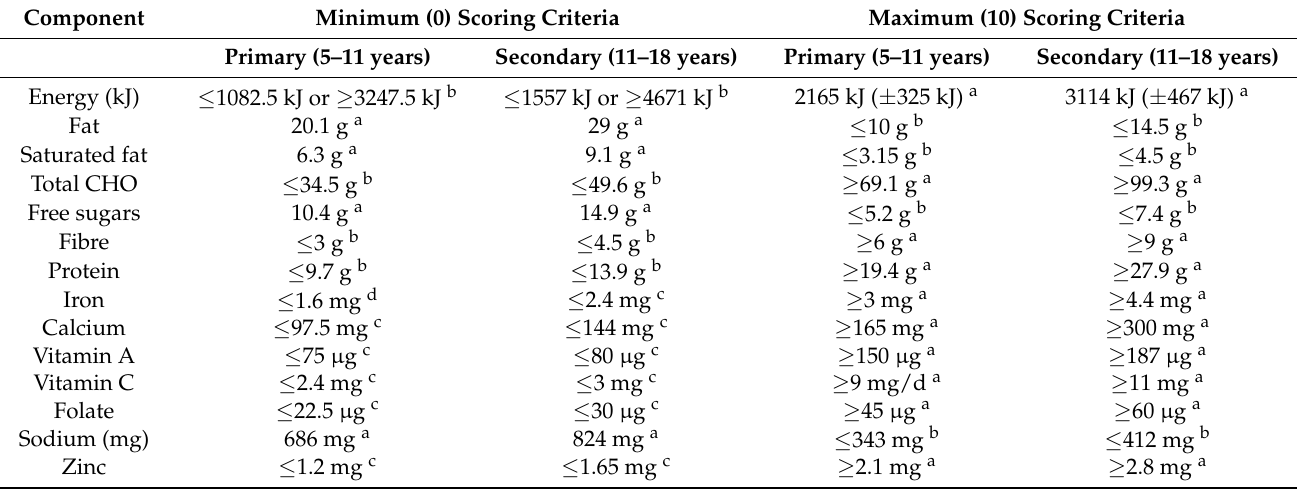
Table 1. Table showing the meal quality index * cut-offs for the lowest (score 0) and highest (score 10) component scores for primary (5–11) and secondary school-aged (11–18)